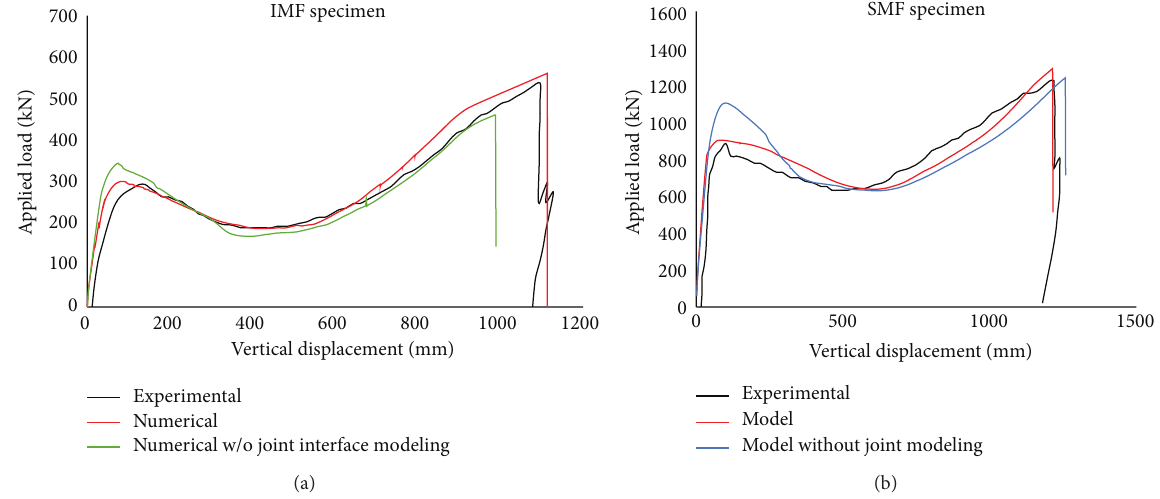
Figure 17: Numerical and experimental load-deflection results for IMF and SMF specimens.